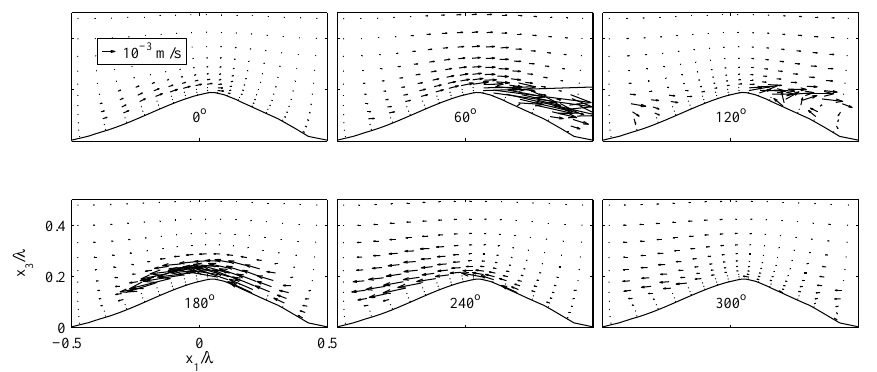
Figure 9. LES results of spanwise-averaged suspended sediment flux for six different phases of the oscillation, assuming a surface roughness of z 0 = d 50 / 4, in the 10th period of oscillation.